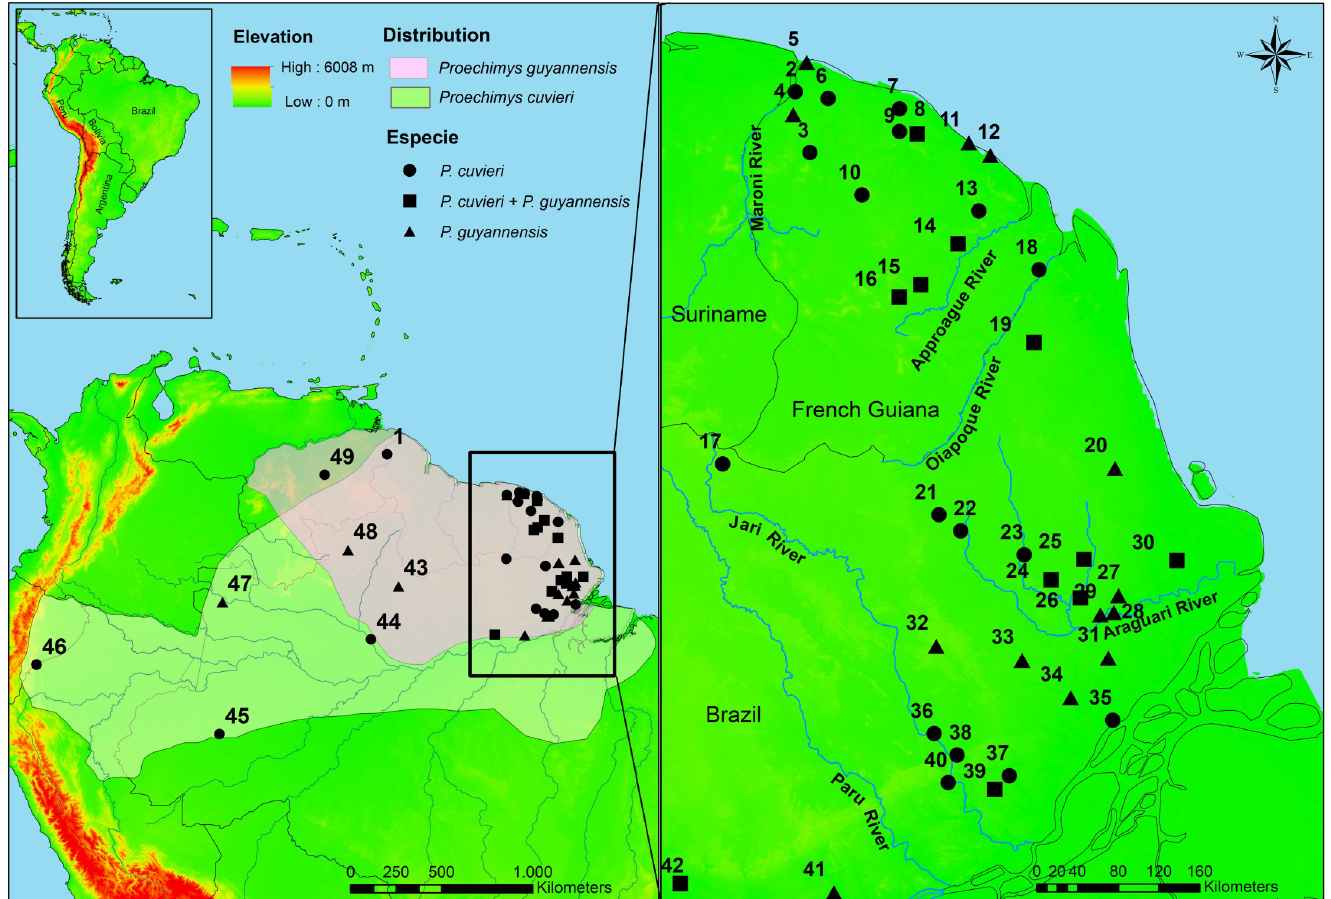
Fig 1. Locations of Proechimys cuvieri and Proechimys guyannensis . Distribution of the species are identified in light green for P . cuvieri and in salmon for P . guyannensis . The numbers identify the locality of the samples: (1) Baramita, (2) Ste Anne, (3) St Jean, (4) Sparouine, (5) Awala, (6) Angoul è me, (7) Piste St Elie, (8) Sinnamary, (9) Petit Saut, (10) Trinite´, (11) Macouria, (12) Cayenne, (13) Piste Belizon, (14) Nouragues, (15) Pic Matecho, (16) Sau¨l, (17) Mapaone, (18) Saint Georges, (19) Anotaie river, (20) Amapa´ Grande river, (21) Anacuı´river, (22) Amapari river, (23) Mutum river, (24) Santo Antonio stream, (25) Brac¸o stream, (26) Falsino river, (27) Tracajatuba river, (28) Ferreira Gomes, (29) Caldeir ã o Falls, (30) S ã o Bento Farm, (31) Horto Matapi, (32) Cupixi river, (33) Vila Nova river-forest, (34) Vila Nova river-savana, (35) Santana Island, (36) Jari river, (37) Marinho Village, (38) Itacara´, (39) Santo Antoˆnio Falls, (40) Porto do Sab ã o, (41) Jatuarana Village, (42) Mamia´ Village, (43) Alto Jatapu, (44) Meduinim Lake, (45) Barro Vermelho, (46) Pico da Neblina, (47) Amazonas, (48) Serra do Apiau´, (49) Bolı´var.